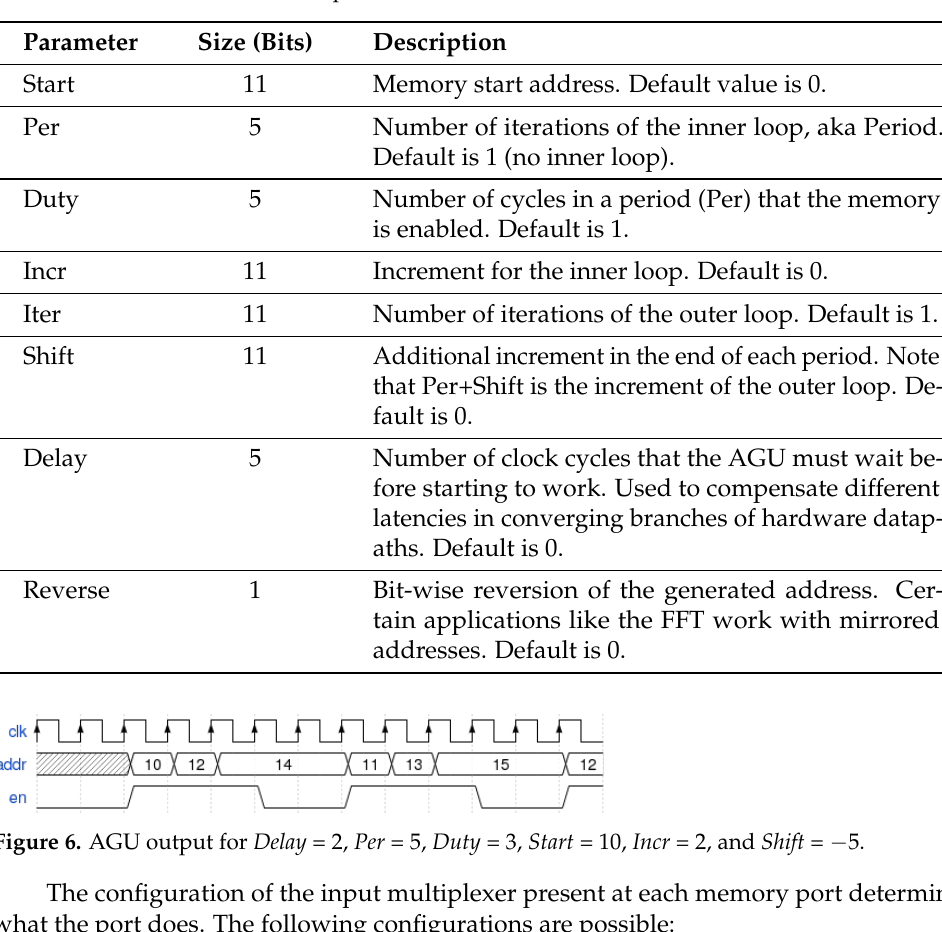
Table 1. Address Generation Unit parameters.